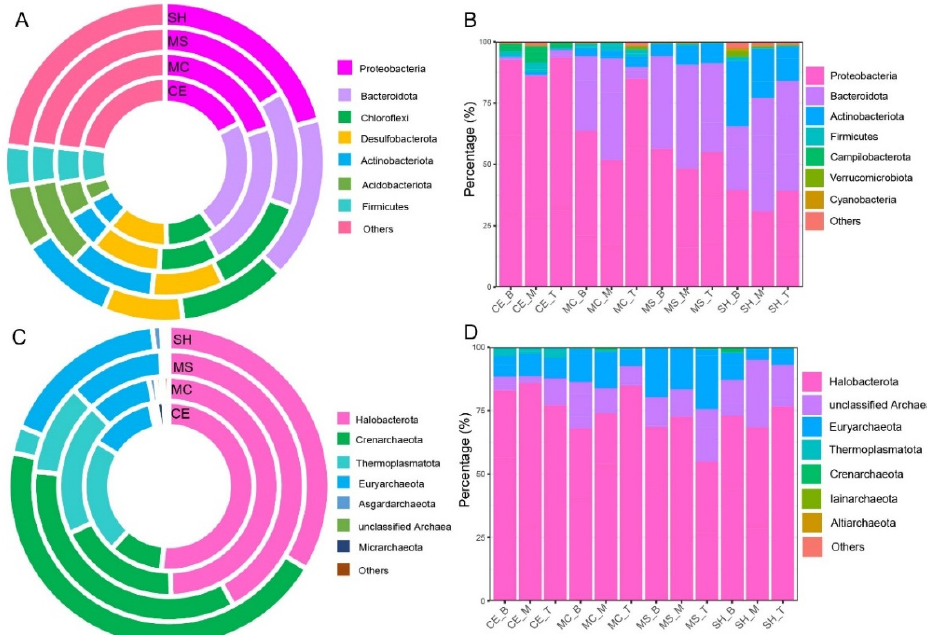
Figure 3. Bacterial and archaeal composition of water and sediment samples from four different sampling points. ( A ) Sediment bacterial composition at the phylum level; ( B ) Water bacterial composition at the phylum level; ( C ) sediment archaeal composition at the phylum level; ( D ) Water archaeal composition at the phylum level. Four sampling points: SH, MS, MC, and CE.